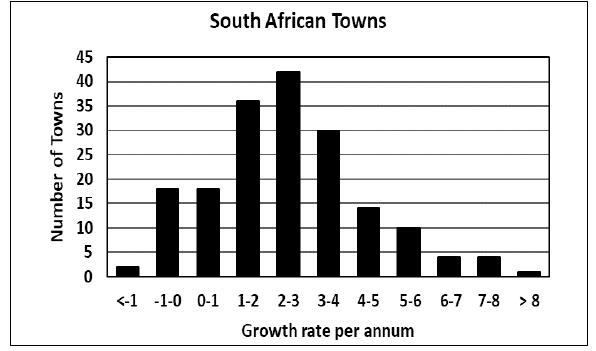
figure 2: Frequency distribution of population growth rates of South African towns between 2001 and 2011.